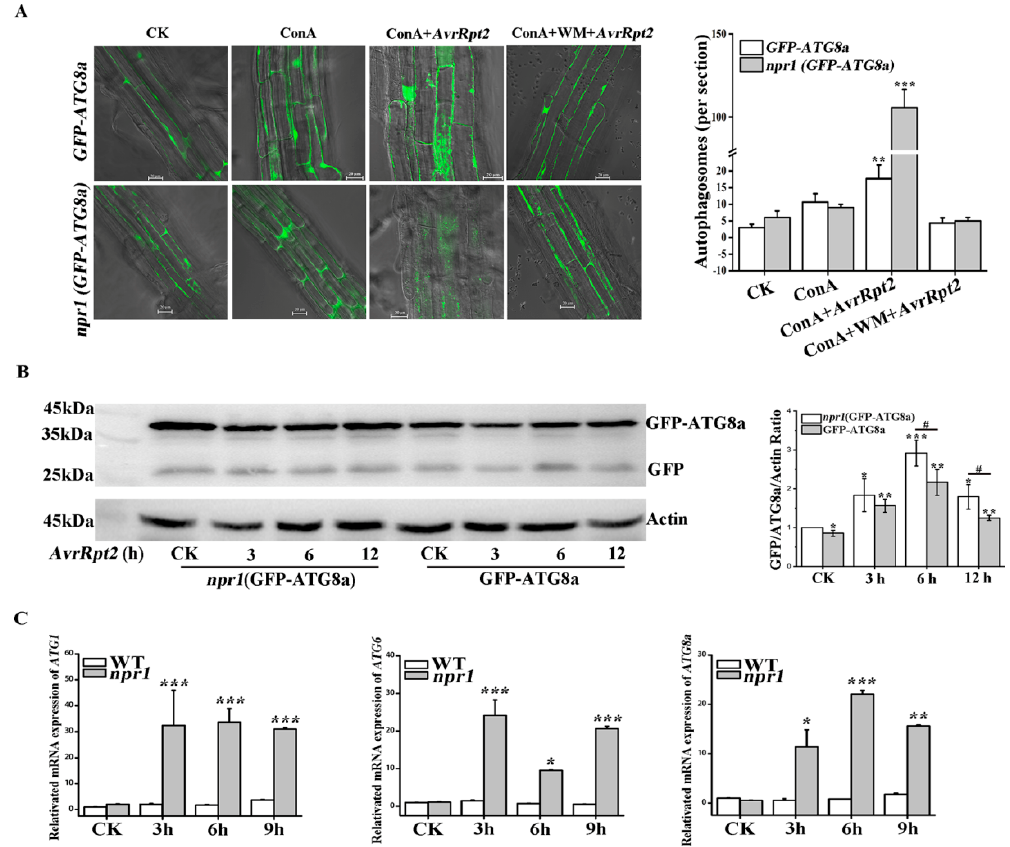
Figure 1. Nonexpressor of PR genes 1 (NPR1) inhibited Psm ES4326 /AvrRpt2 (AvrRpt2)